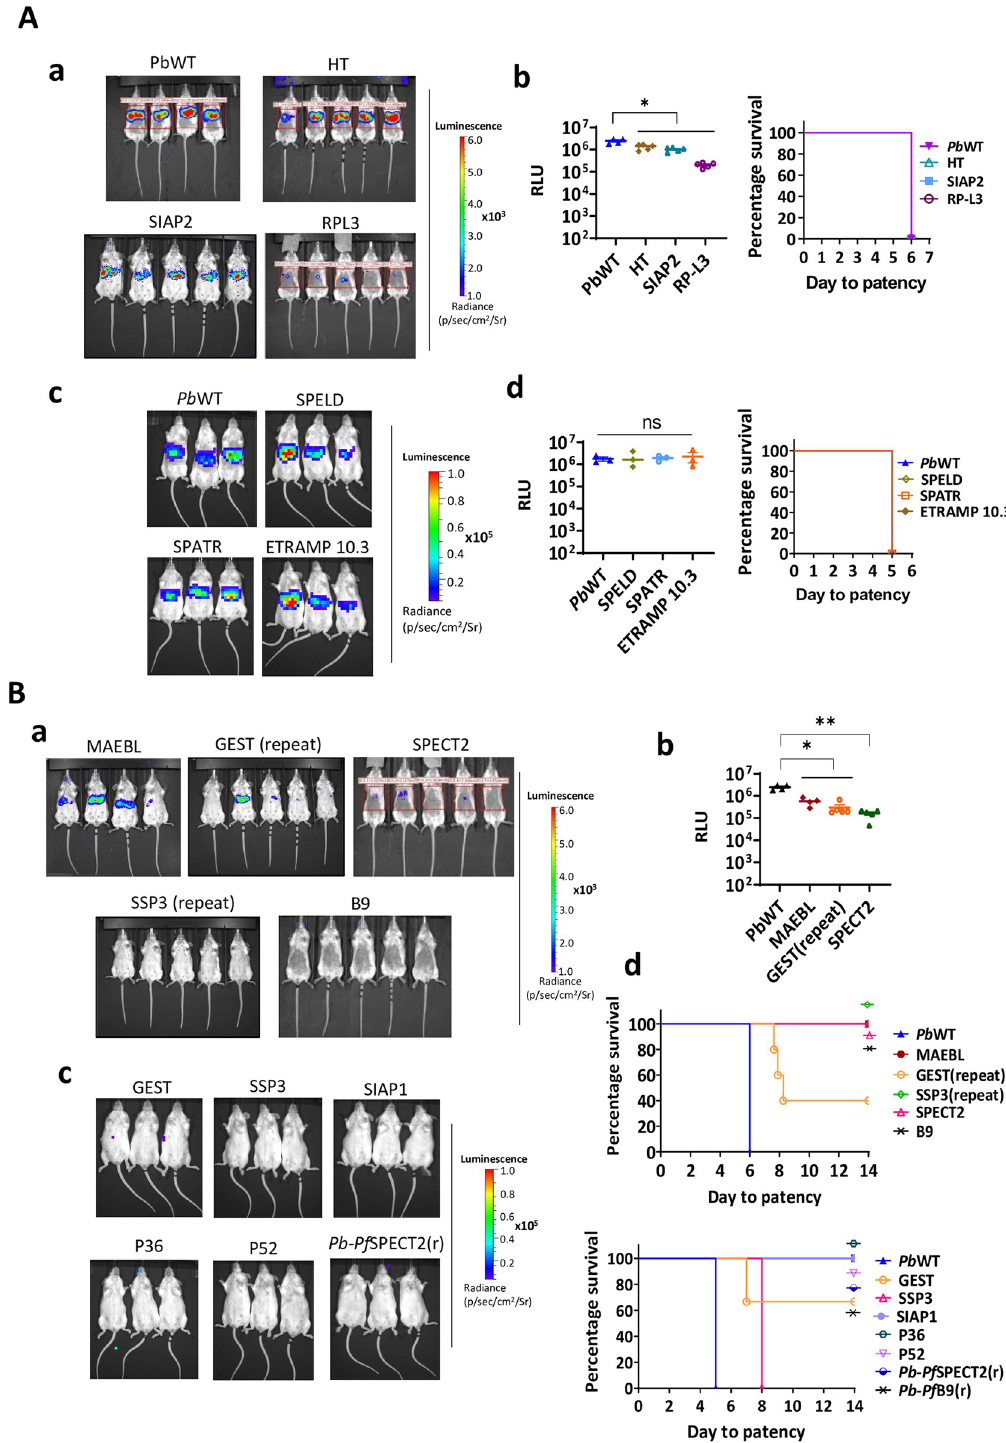
Fig 1. Sporozoite infectivity of chimeric P . berghei lines expressing P . falciparum proteins. Sporozoite infectivity is determined by measuring parasite liver load by in vivo imaging of luciferase-expressing liver stages at 44 hours post injection (hpi) of either 1x10 3 or 1x10 4 sporozoites and by measuring the day to blood stage patency, i.e. the day to reach 1% parasitemia. The Kaplan-Meier curves illustrate the prepatent period. Data shown from groups of 3–5 mice. ( A ) Chimeric P . berghei lines that showed WT-like infectivity in mice. a ) Representative in vivo imaging (IVIS) of bioluminescence at 44 hpi shown in the livers of OF1 mice infected with 1x10 3 chimeric P . berghei sporozoites of HT, SIAP2, and RPL3. b ) Parasite liver loads in mice